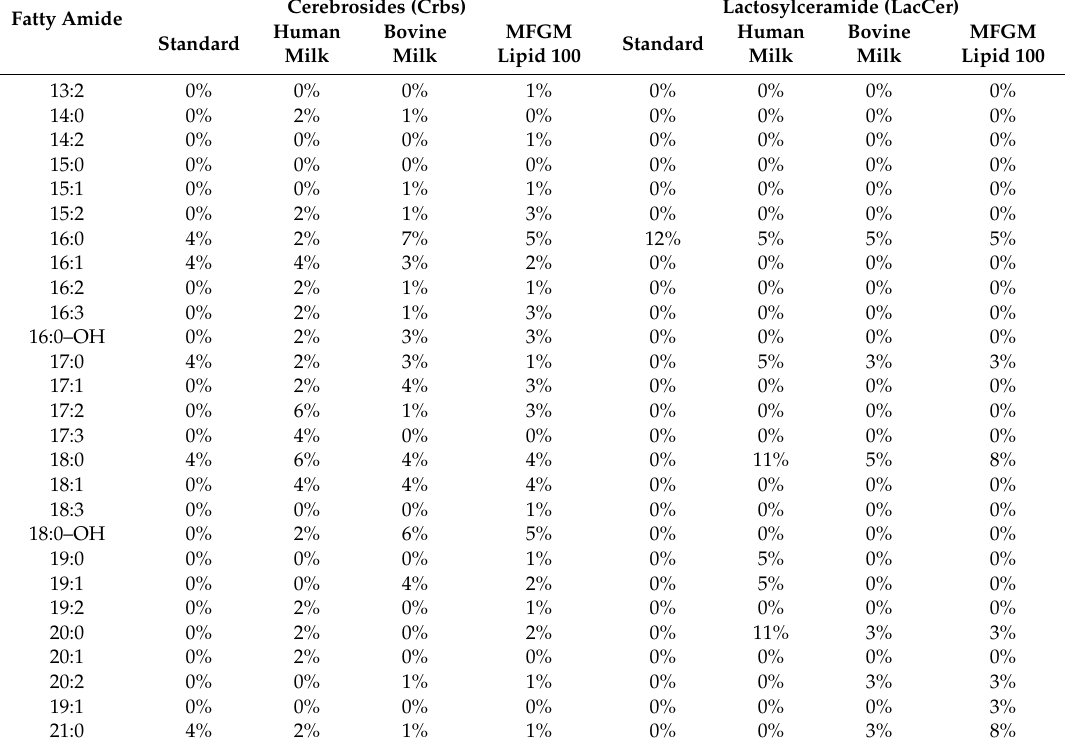
Table 2. Proportion of distinct species containing specific fatty acids in commercial standards, human milk a , bovine milk and MFGM Lipid